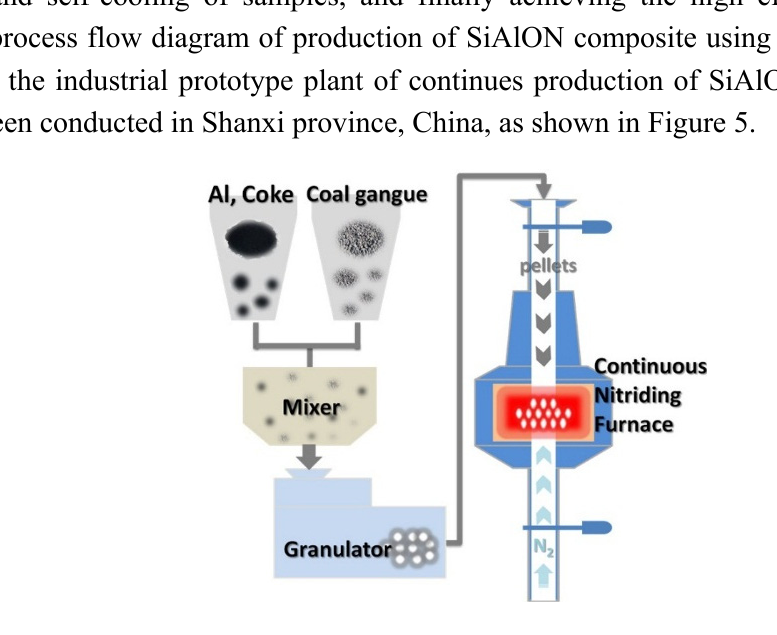
Figure 4. Process flow diagram for SiAlON production using coal gangue.